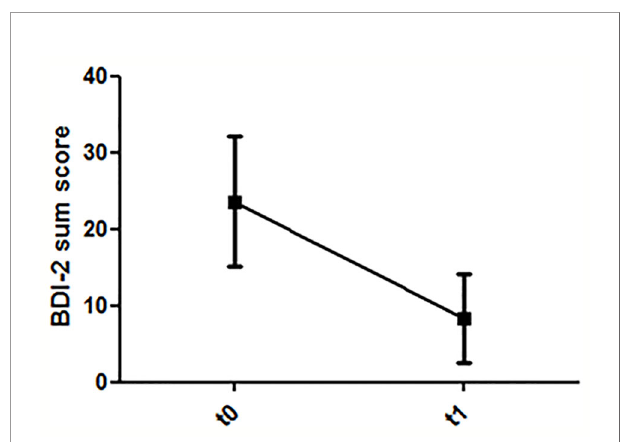
Figure 3 ). Number of therapy sessions: 26 (± 14), sessions until RTW: 9 (± 9).